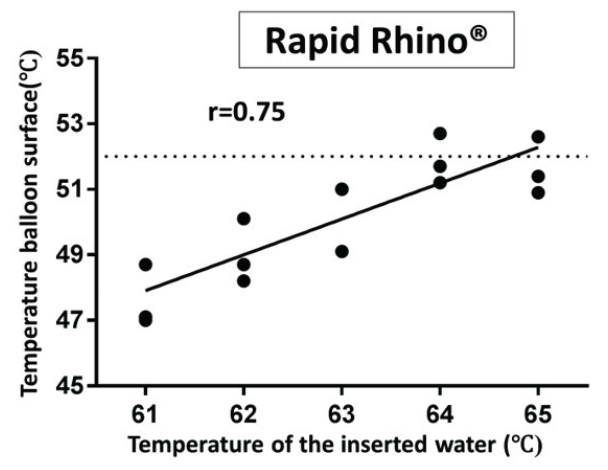
Figure 3. Water temperature versus maximum balloon surface tempera- ture for Rapid Rhino®. Please note that there is, as expected, a linear relationship between water temperature and maximum surface temper- ature. The dotted line indicates maximum surface temperature of 52 0C , which has been shown to be the threshold for necrosis of nasal